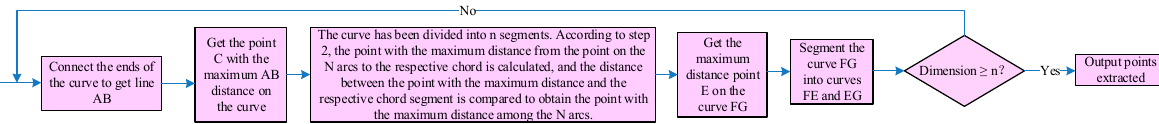
Figure 1. Improved Douglas–Peucker algorithm flow chart.